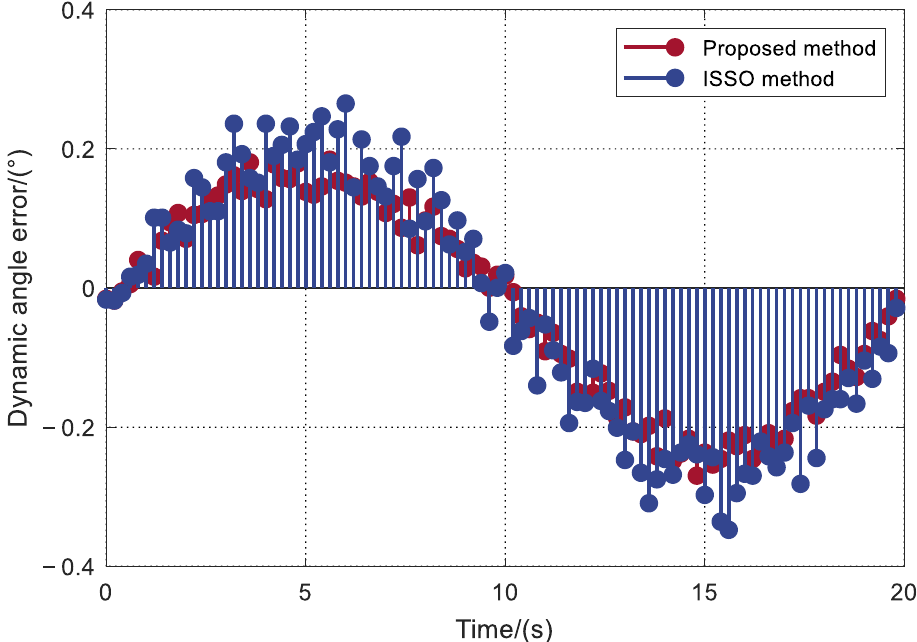
Figure 10. Dynamic rotation angle error.